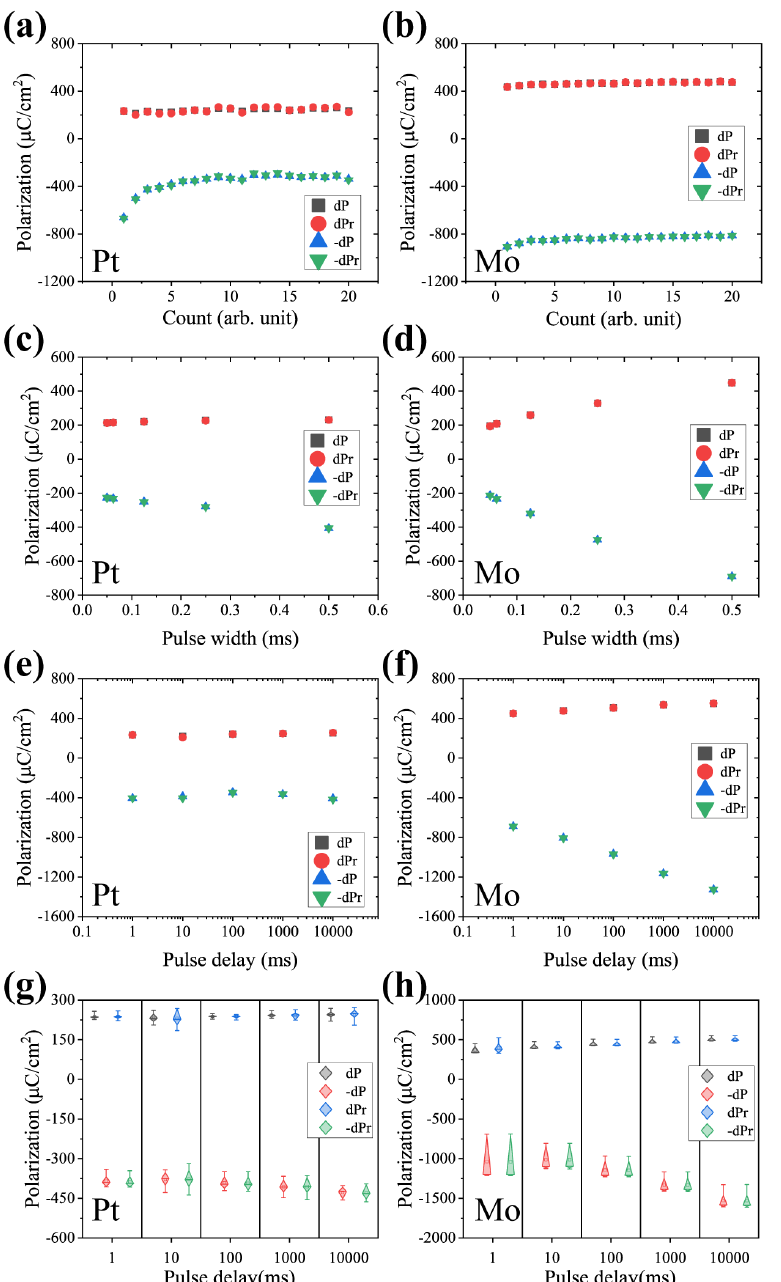
Figure 9. PUND measurements under different conditions. Repeat test at fixed V max = 60, V, pulse width = 0.5 ms and pulse delay = 10 ms: ( a ) Pt and ( b ) Mo. V max and pulse width were kept constant: 60 V and 0.5 ms, pulse delay set to 1, 10, 100, 1000 and 10,000 ms. ( c ) Pt and ( d ) Mo. Pulse width was taken as 0.5, 0.25, 0.125, 0.625 and 0.05 ms. In addition, V max = 60 V, pulse delay = 1 ms. ( e ) Pt